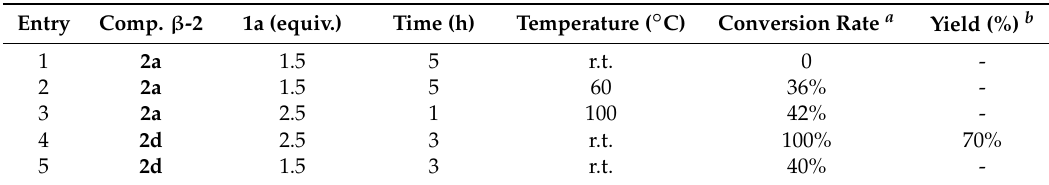
Table 1. Survey of reaction conditions for the coupling of tetra- O -acetylated 1-thio- β - D -galactopyranose 1a with 3-halo N -glucosylquinolinone β - 2a , d . Comp. β